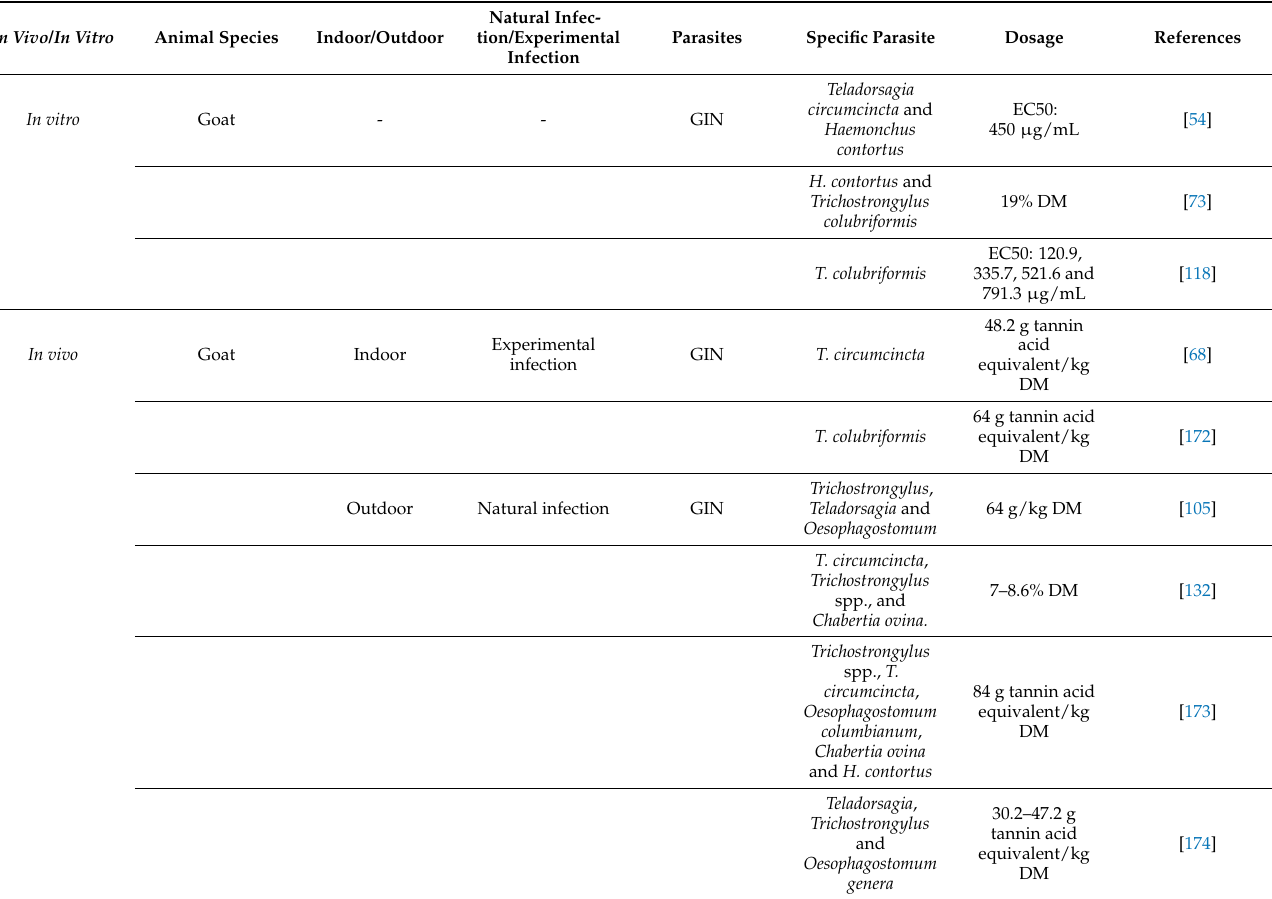
Table 4. Brief description of trials for the antiparasitic plant: Ericaceae